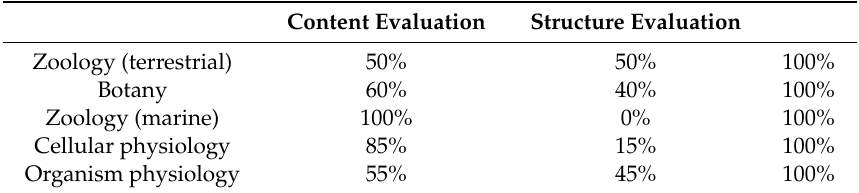
Table 3. Percentage breakdown of the codes generated for the content and structure